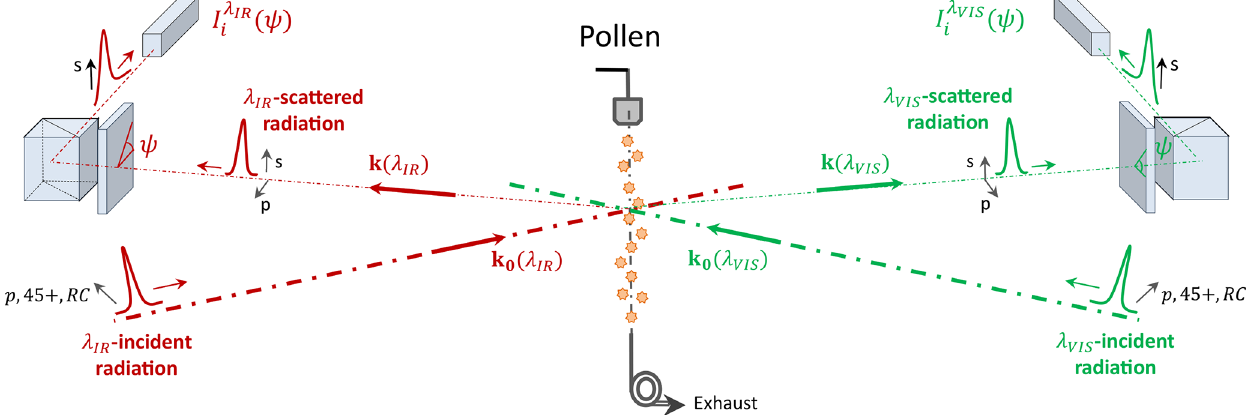
Figure 2. Scheme of the laboratory experimental set-up of the ( λ VIS , λ IR ) polarimeter from Cholleton et al. (2020). The 177.5 ◦ scattering angle has been exaggerated to ease the reading. k 0 (λ) and k(λ) respectively stand for the incident and scattered wave vectors at wavelength λ . Pollen grains are embedded in laboratory ambient air as described in Sect. 2.5. ψ is the angle between the fast axis of the quarter-wave plate (QWP) and the scattering